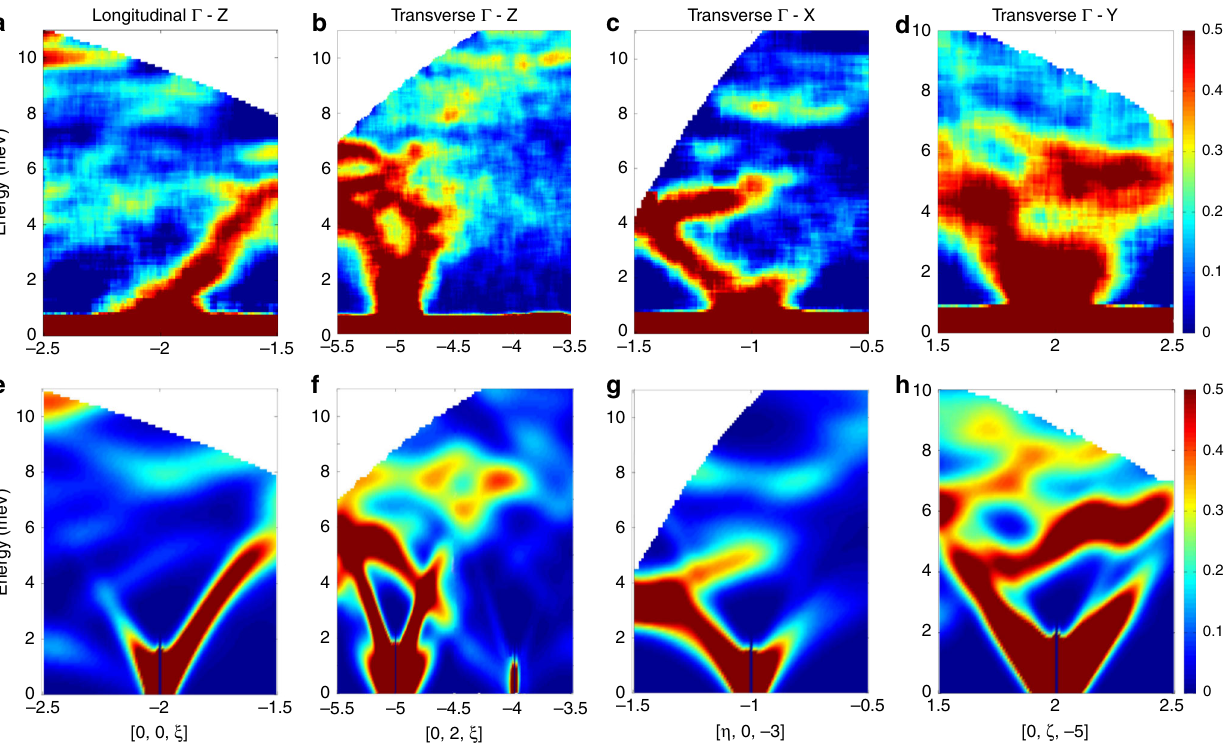
Fig. 4 Phonon dispersions up to 11 meV. In a – d we show representative examples of [VO(acac) 2 ] phonon dispersions measured on LET with E i = 13 meV and T = 5 K. Dispersions curves have been obtained integrating over two out of the three components of the neutron scattering vector Q ¼ ½ η ; ζ ; ξ (cid:2) (expressed in terms of reciprocal lattice vector units) around different Bragg peaks. a Shows longitudinal acoustic modes along the symmetry direction Γ – Z around [0, 0, − 2], as in Fig. 3a. With this incident energy we have been able to resolve not only the acoustic but also optical phonon modes up to 11 meV. b – d Display transverse modes along three principal symmetry directions: Γ – Z around [0, 2, − 5] and [0, 2, − 4], Γ – X around [ − 1, 0, − 3] and Γ – Y around [0, 2, − 5]. The colour bar reports the intensity normalised for the maximum in each panel. Simulated dispersion curves along the same directions are reported in e – h and were calculated with Eq. (3) (see Methods), with phonon energies and polarisation vectors obtained from